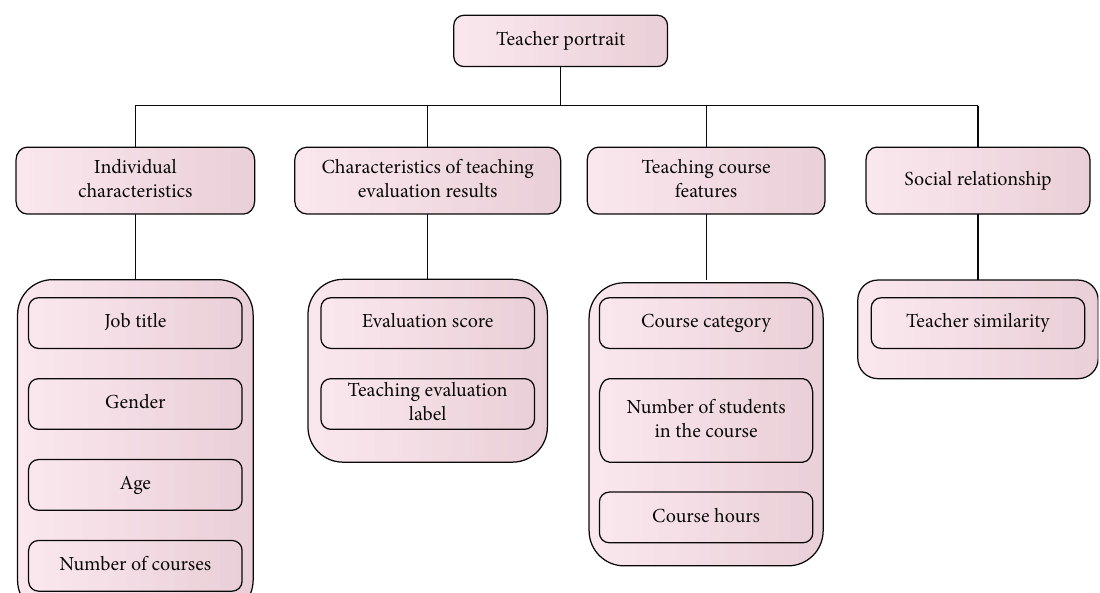
Figure 2: Index architecture diagram of teacher